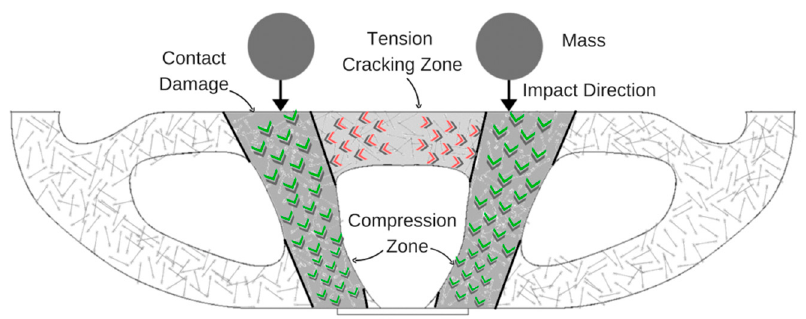
Figure 14. Failure mechanism [22].